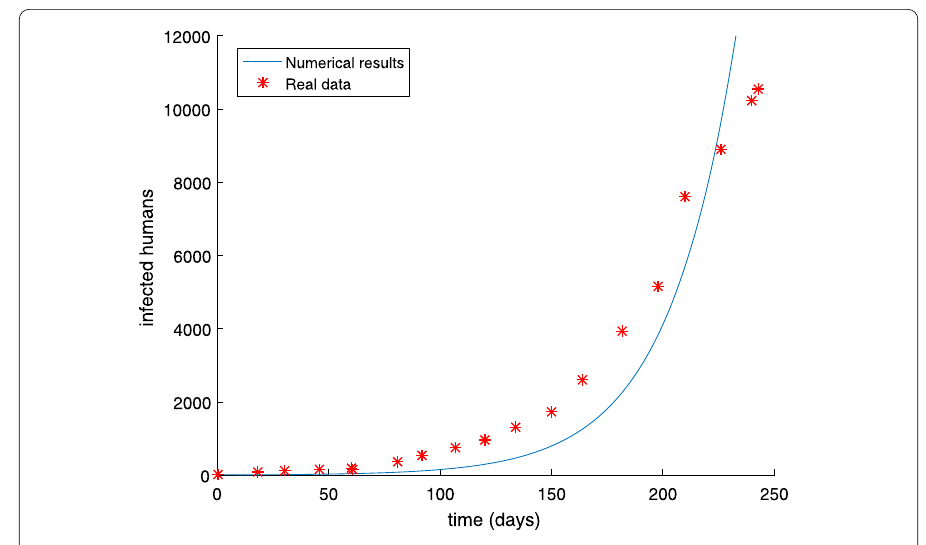
Figure 1 The number of Ebola infections I ( t ) in Guinea, Liberia, and Sierra Leone compared with the numerical results of classical model (6) obtained by ODE45 function. The values of the parameters are β = 0.2305, m = 80, q = 0.0300 and the root-mean-square relative error is g ( U ) =